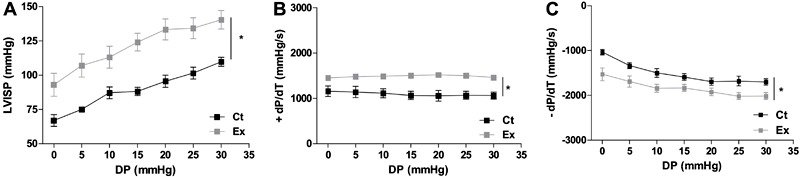
Contractility values from isolated heart. A, left
ventricular isovolumetric systolic pressure (LVISP); B,
positive first time derivative (+dP/dt), and C, negative first
time derivative (−dP/dt) curves obtained at different diastolic pressures (DP)
from control (Ct, n=6) and exercised (Ex, n=6) spontaneously hypertensive rats
(SHR). Results are reported as means±SE. *P<0.05 (two-way ANOVA).